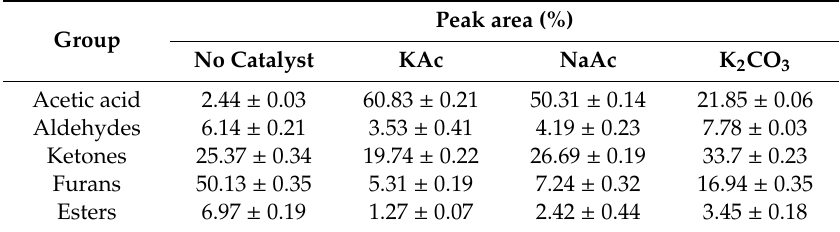
Table 5. Peak area % of the typical products obtained from the glucose in situ catalytic pyrolysis with KAc, NaAc, K 2 CO 3 and without catalyst at 350 ◦ C for 30 s. Peak area Group